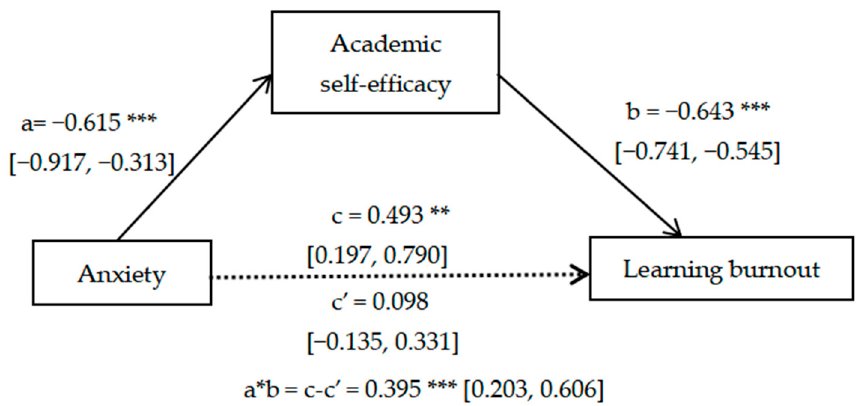
Figure 1. Mediating effect of academic self-efficacy on anxiety and learning burnout. ** p -value < 0.01, *** p -value < 0.001.